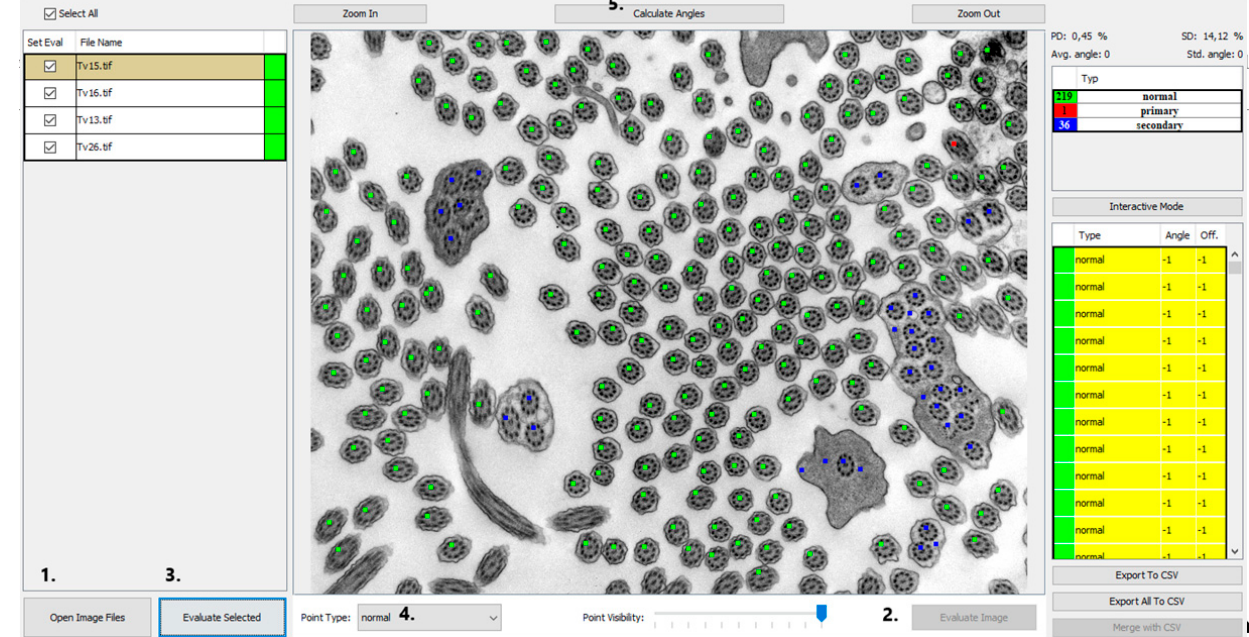
Figure 2. PCD Quant, the main window (the same photo as in Figure 1). This view presents a window displaying a list of loaded images in the left panel, color points on the detected cilia in the central image and the computed statistics in the right panel. The numbers direct to main control buttons: load images ( 1. ), evaluate current image ( 2. ), evaluate all selected images ( 3. ), select annotation point ( 4. ) and calculate angles ( 5. ) This photo was selected as an example of how PCD Quant works without further editing. Compared to the manual evaluation, a difference can be seen in the number of cilia marked as “primary”, meaning primary defects. PCD Quant was able to detect one primary defect as opposed to two when manually evaluated in NIS Elements (Figure 1). A difference is also observable in detection of secondary defects (36 versus 33 in the manual evaluation).